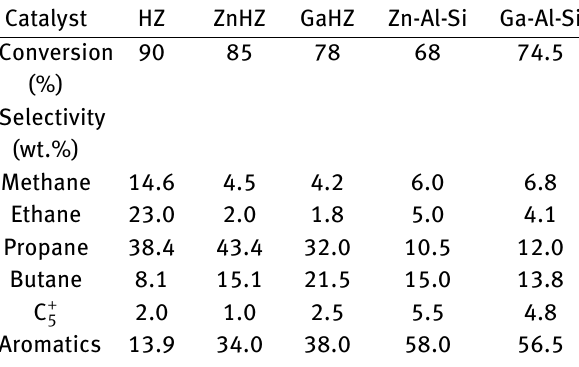
Table 6: Performance of metal modified ZSM-5 catalysts in